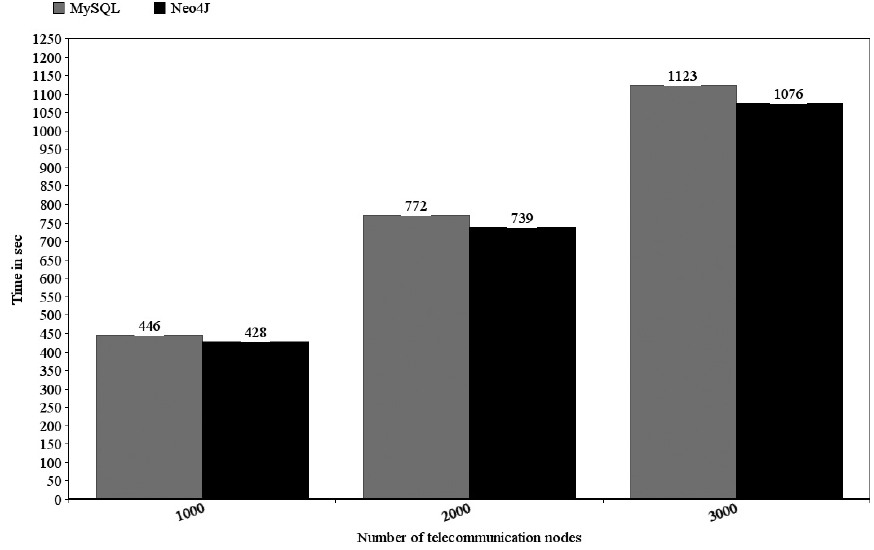
Fig. 4. Processing and insertion